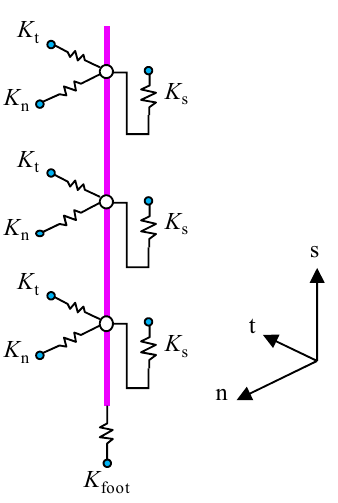
Figure 2. Stiffness of the embedded interface elements at the skin of the pile.